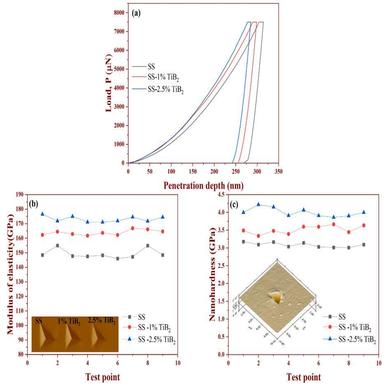
(a) Nanoindentation load-penetration depth curve, (b) Elastic modulus and (c) nanohardness of pore-gradient materials with different vol% of TiB2 nanoparticles.